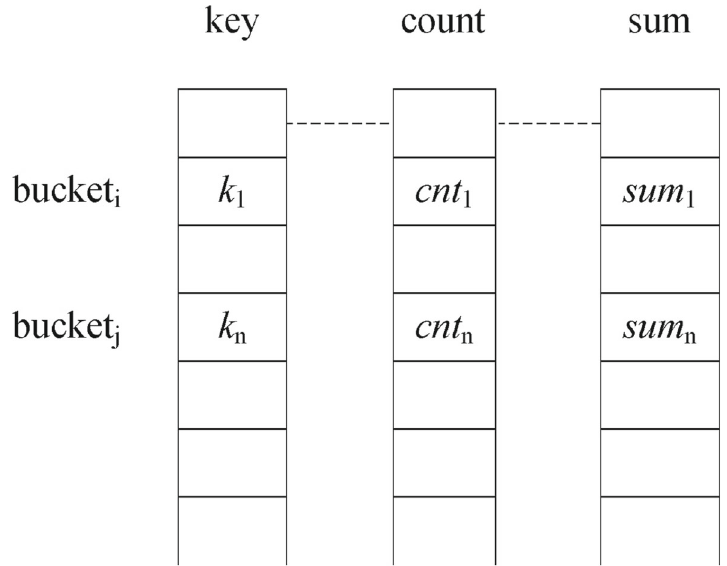
Fig. 2 Linear probing